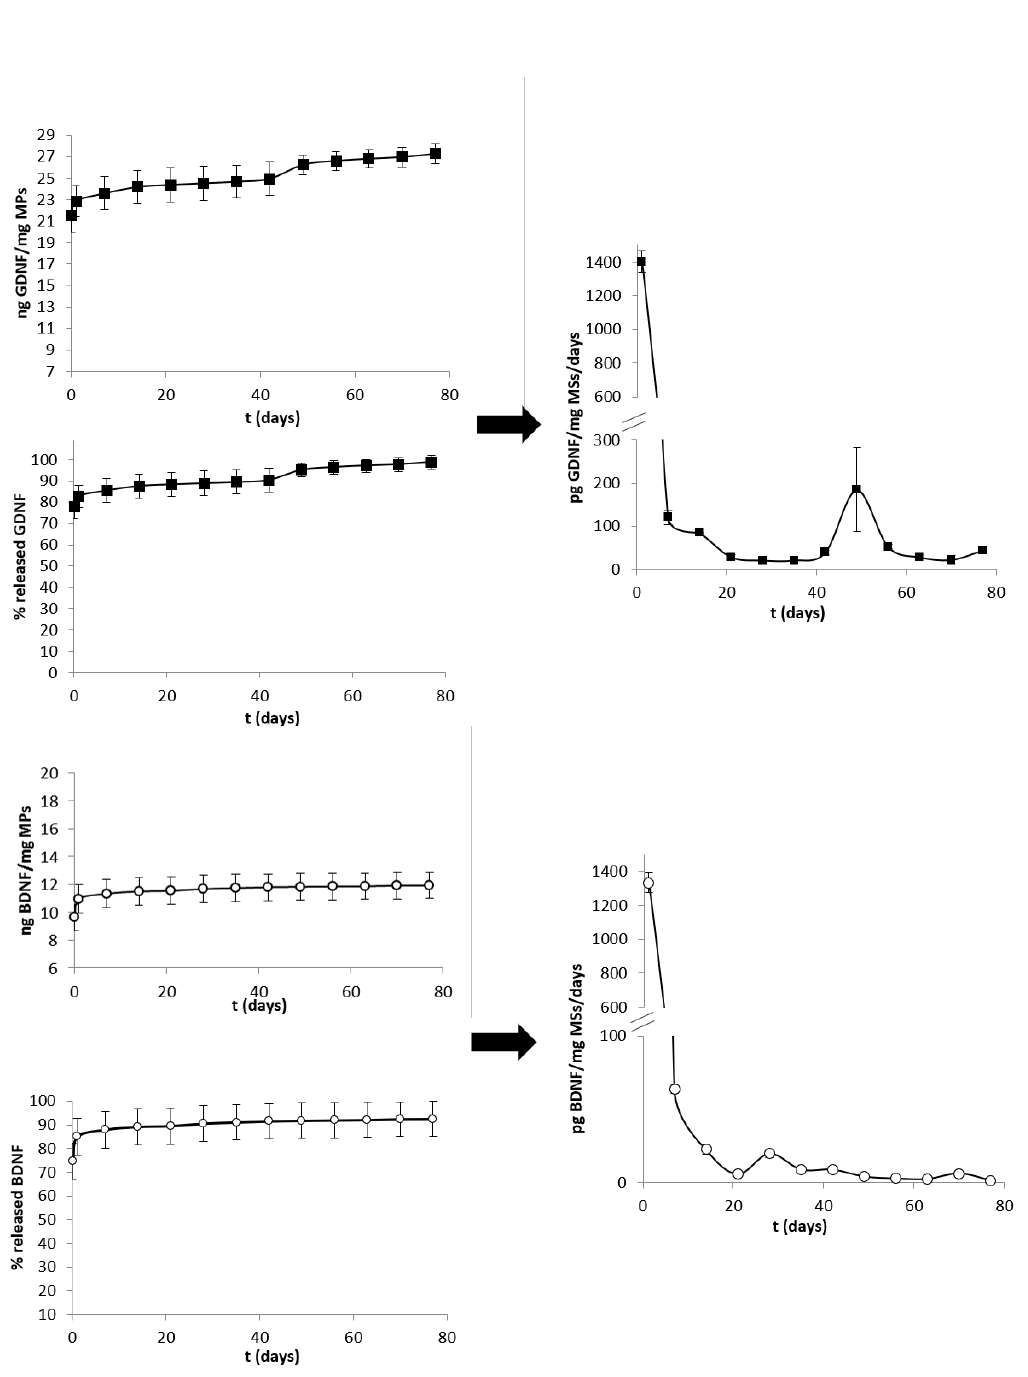
Figure 2. Release profiles of NTFs from PLGA/VitE matrices are presented expressed as cumulative ng NTF/mg MSs, cumulative % of total loaded protein and the release rate of NTF (pg NTF/mg MSs/day). ( A ) GDNF release from GDNF-loaded MSs. ( B ) GDNF ( ■ ) and BDNF (o) release from GDNF/BDNF-loaded MSs. Release media: PBS (pH 7.4) with 1.0% of BSA and 0.02% sodium azide.